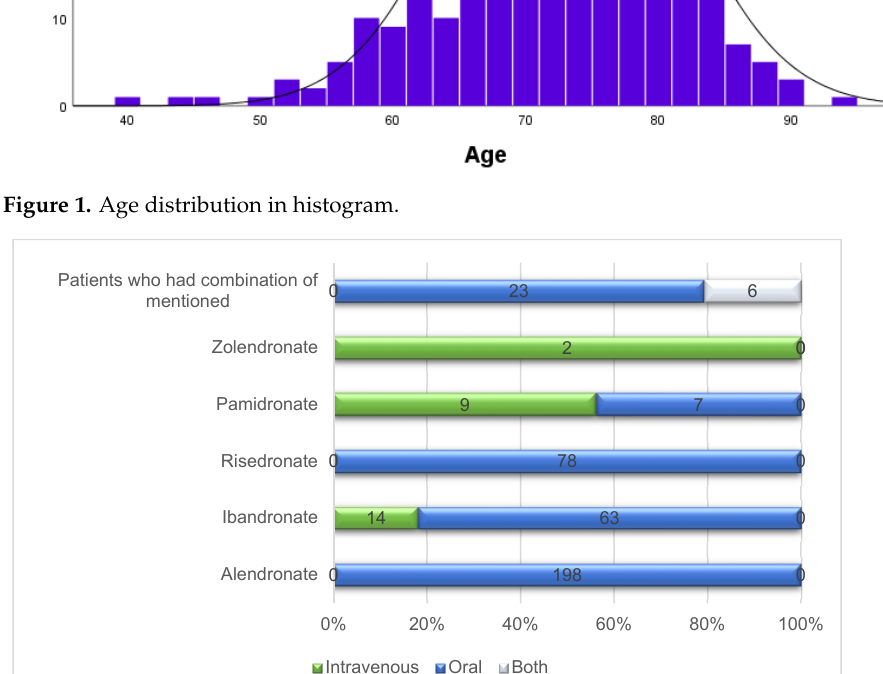
Figure 2. Distribution of bisphosphonates by administration route.